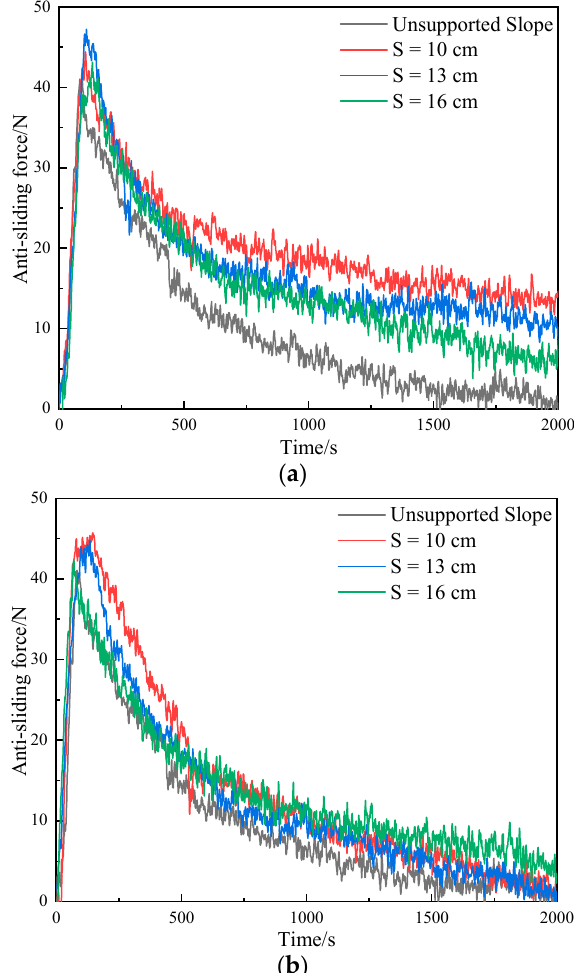
Figure 8. Effect of plant spacing of tap-like root system on anti-sliding force with constant root volume. ( a ) Square distribution; ( b ) Staggered distribution.